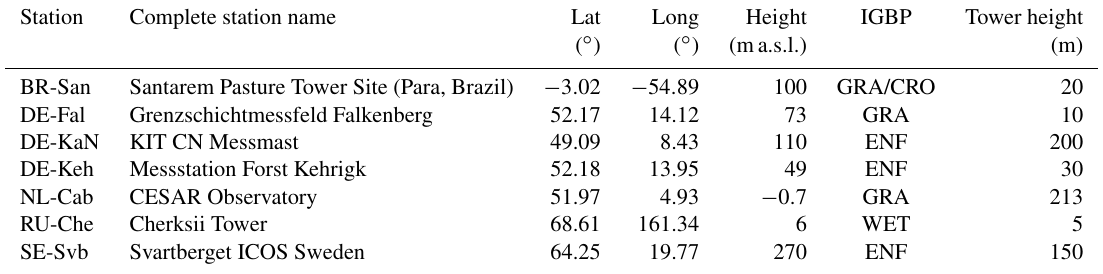
Table 1. Station information for the meteorological towers selected for training and validation (see Sect. 2.4); a list of all stations is given in Table A1. Land usage classification follows the International Geosphere–Biosphere Programme (IGBP) standards: evergreen needle-leaf forests (ENF), grasslands (GRA), permanent wetlands (WET) and croplands (CRO).